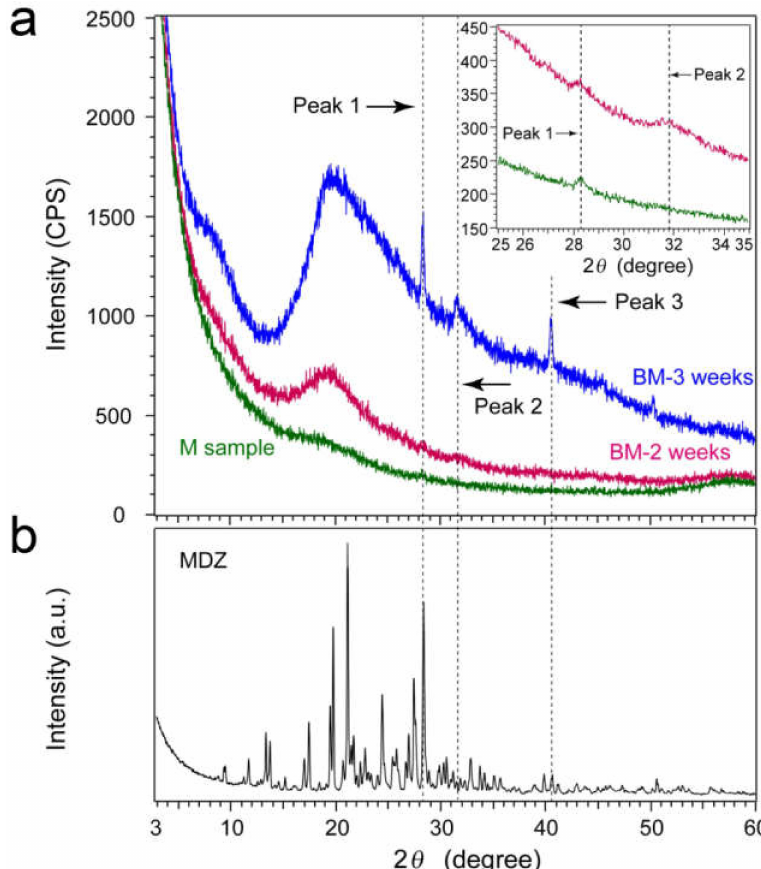
Figure 6. ( a ) Continuous-scanning XRD patterns of sample after three weeks of cell culture (blue), two weeks of cell culture (magenta), and without β -glycerophosphate (green). Inset small panel corresponds to patterns for blue and magenta curves measured by step scanning mode. ( b ) Continuous-scanning XRD pattern of